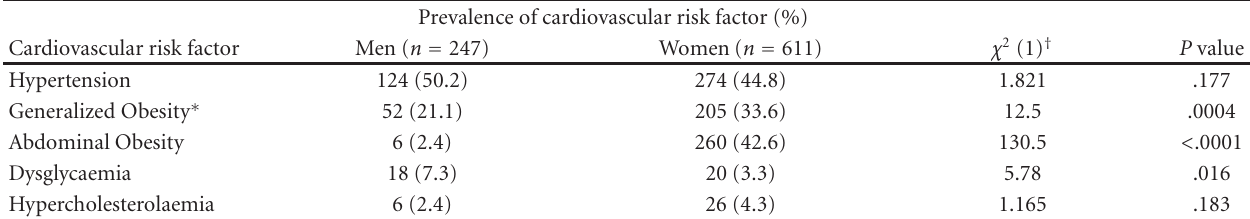
Table 2: The prevalence of the risk factors by